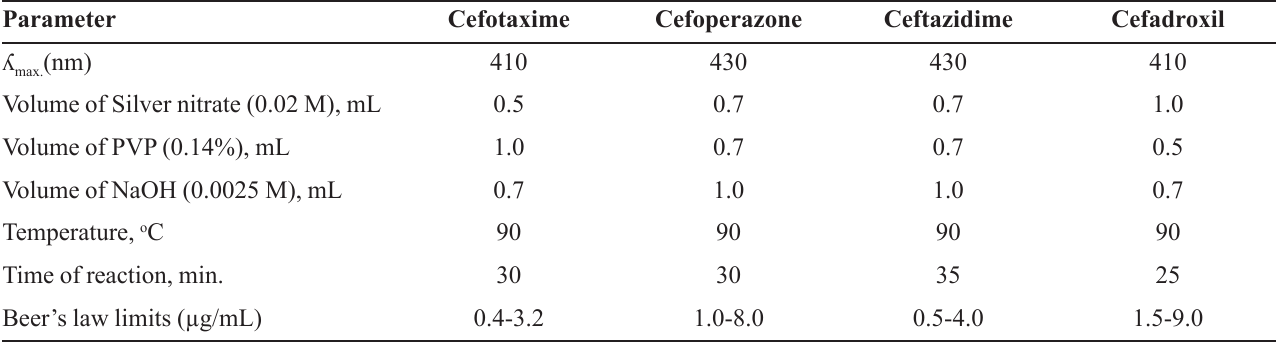
TABLE I – The analytical parameters for the determination of cefotaxime, cefoperazone, ceftazidime and cefadroxil through silver nanoparticles